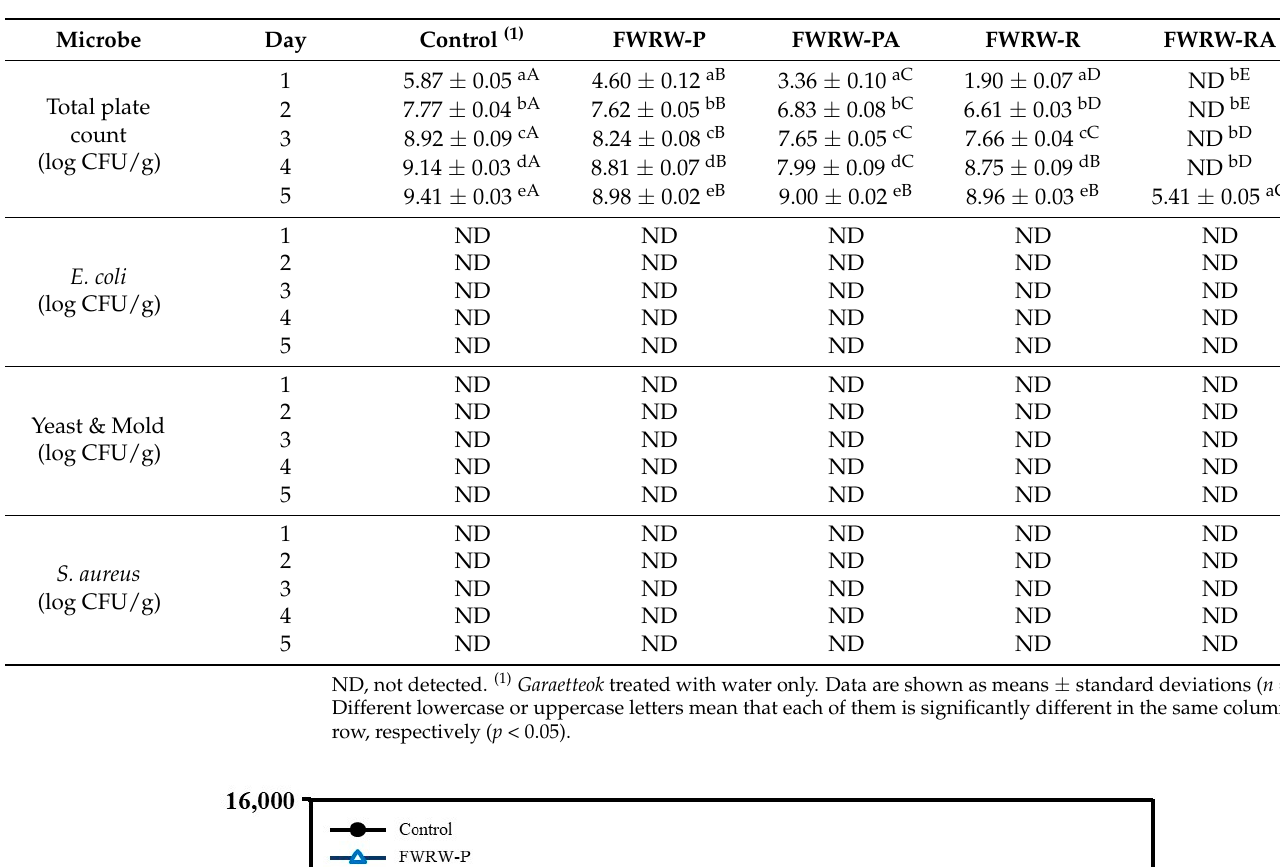
Table 2. Comparison of the microbes detected during storage under various FWRW treatments of garaetteok .